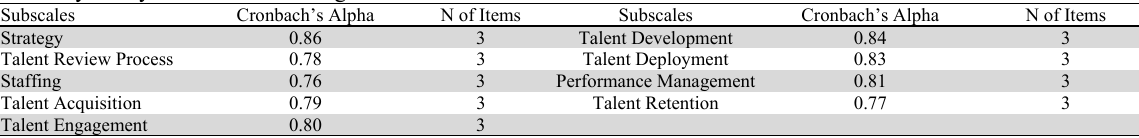
Reliability Analysis for Talent Management Practices Subscales